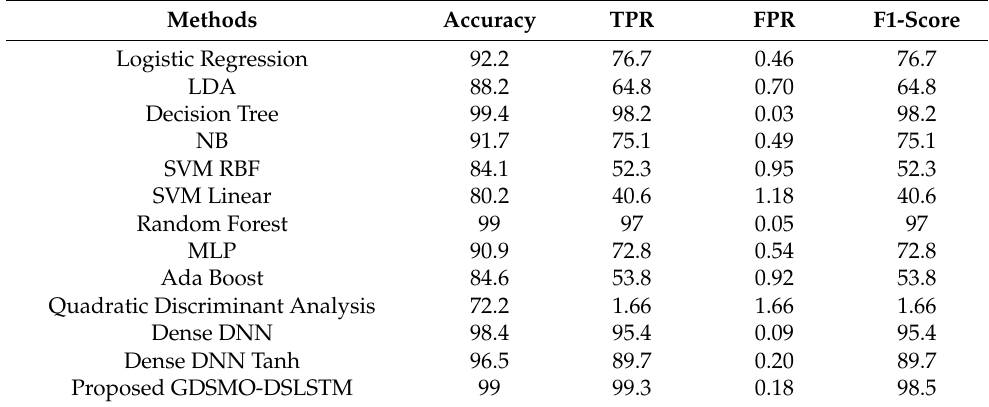
Table 3. Comparative analysis between existing and proposed mechanisms using the CSE-CIC-IDS 2018 dataset.